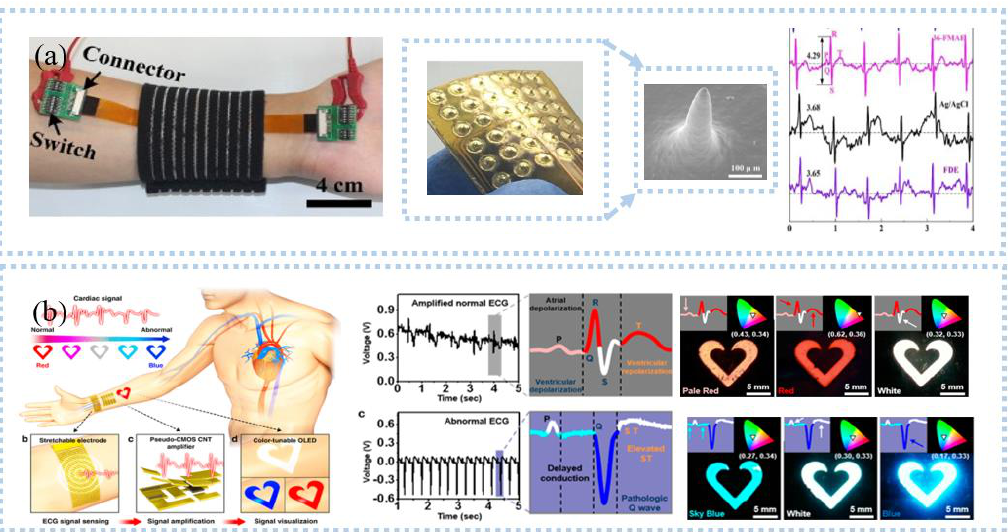
Figure 2. ECG signal detection: ( a ) ECG sensor with microneedle electrodes collected ECG at the wrist and compared with wet electrodes and dry electrodes. Reprinted with permission from Ref. [26]. Copyright 2017 Elsevier, ( b ) organic light − emitting device used for ECG monitoring and the collected ECG was visualized. Reprinted with permission from Ref. [36]. Copyright 2017 American Chemical